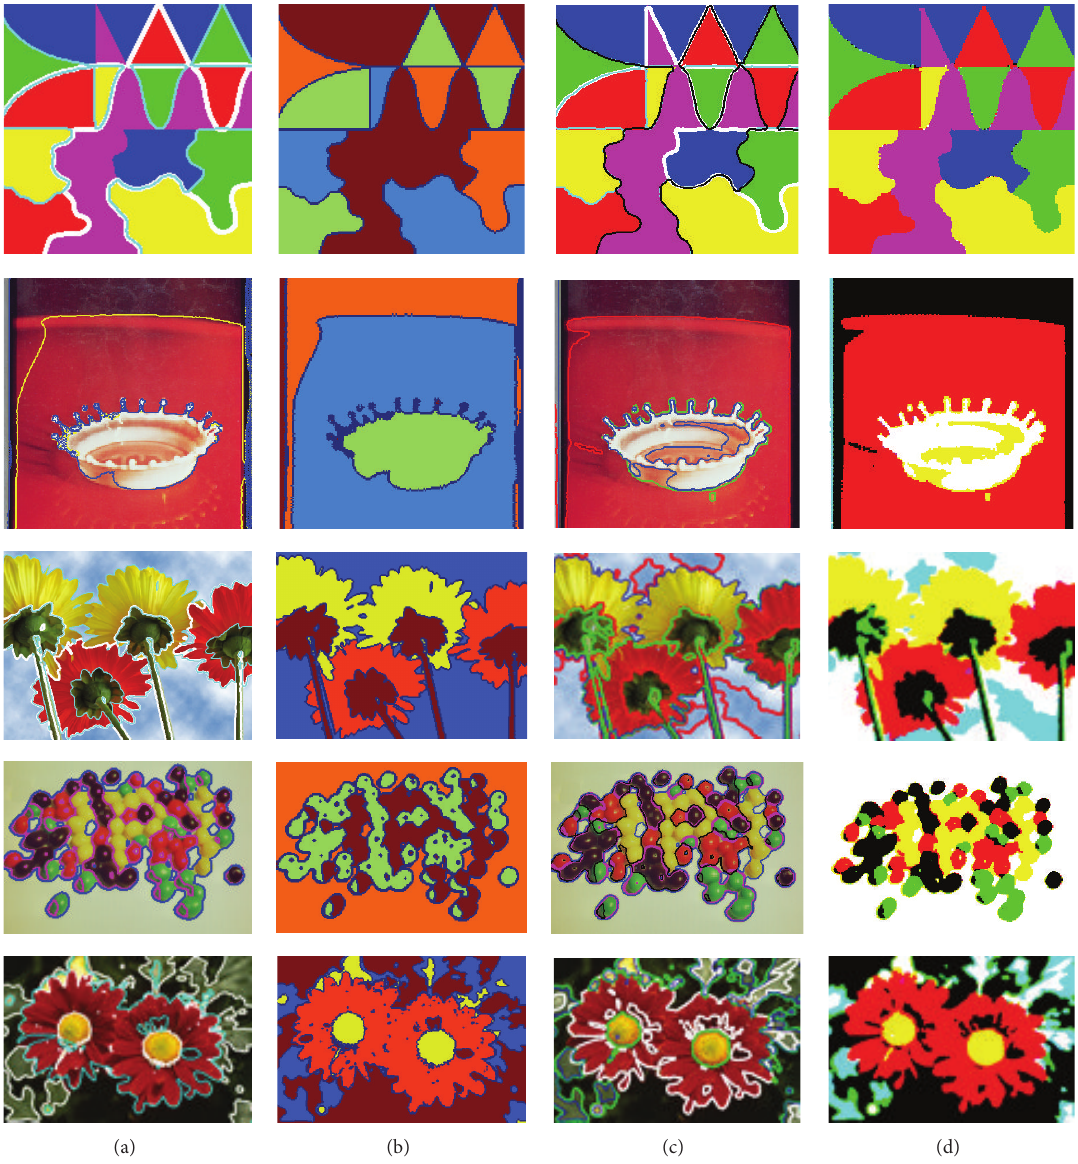
Figure 5: Results for a group of images; (a) the corresponding final contours of FMLSM; (b) the corresponding final segmented images of FMLSM; (c) final contours of the proposed model; (d) results of the proposed